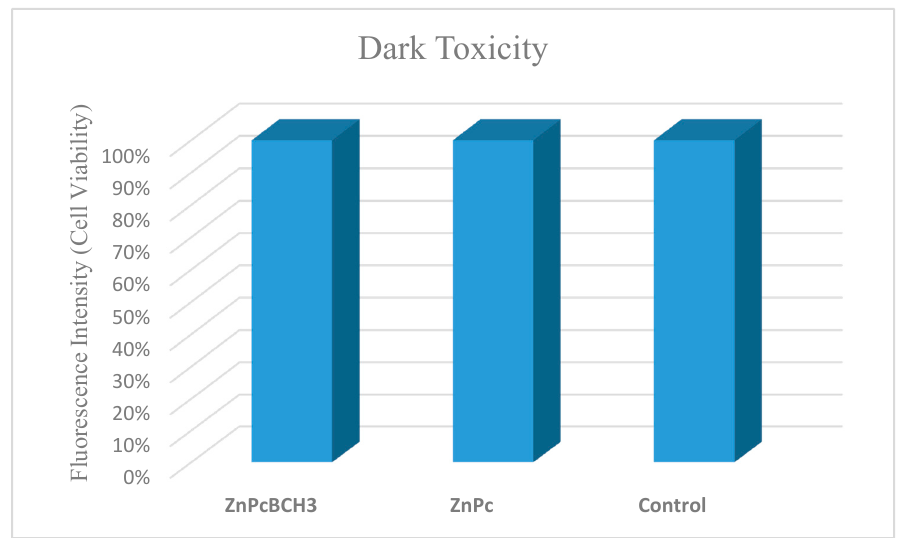
Figure 9. Dark toxicity results following a 24-h treatment of A549 cells with 80 nM ZnPc or ZnPcBCH 3 and 2% DMSO (control) using the CTB assay.